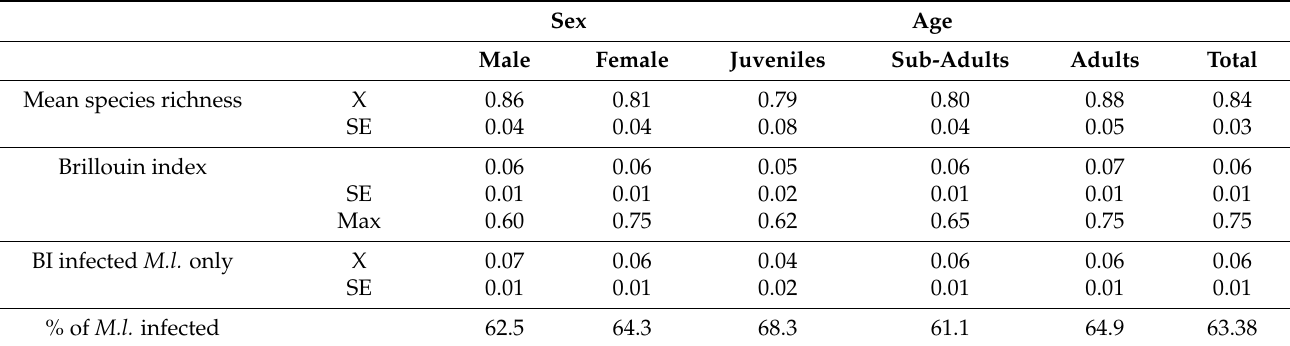
which follow a similar trend as the helminth community diversity. Table 11. Diversity characteristics of helminth infracommunities of Microtus lusitanicus ( M.l. ) from Asturias by host sex and age. SE—standard error.